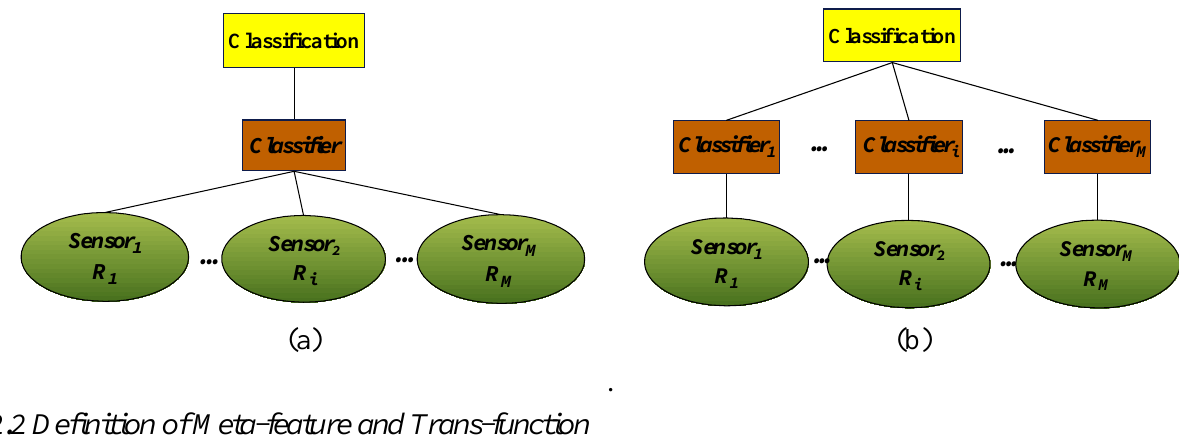
Figure 1. Demonstration of (a) feature-level fusion and (b) decision-level